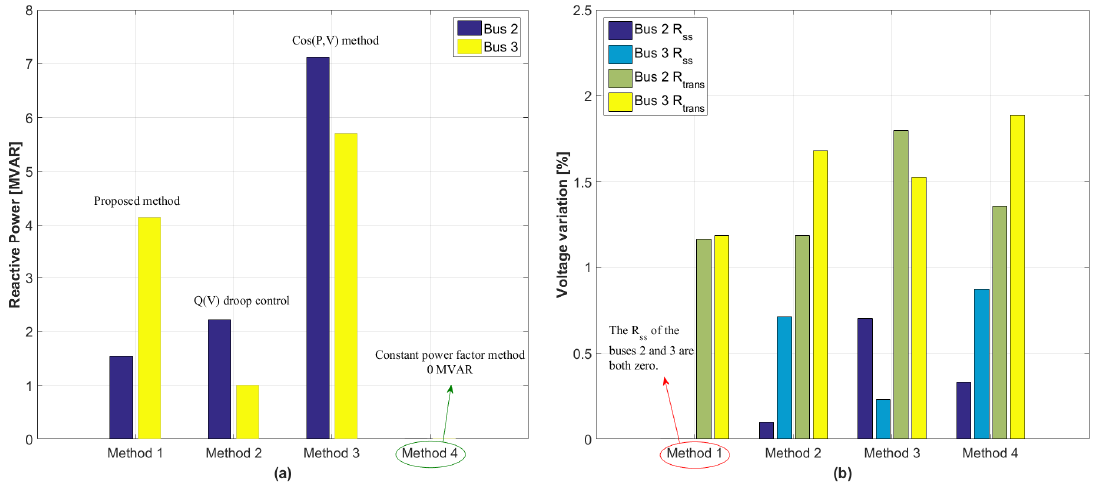
Figure 12. Comparison results for minimization of voltage variation in Case 3. ( a ) Total reactive power generation at buses 2 and 3 ( b ) Voltage variation at buses 2 and 3.